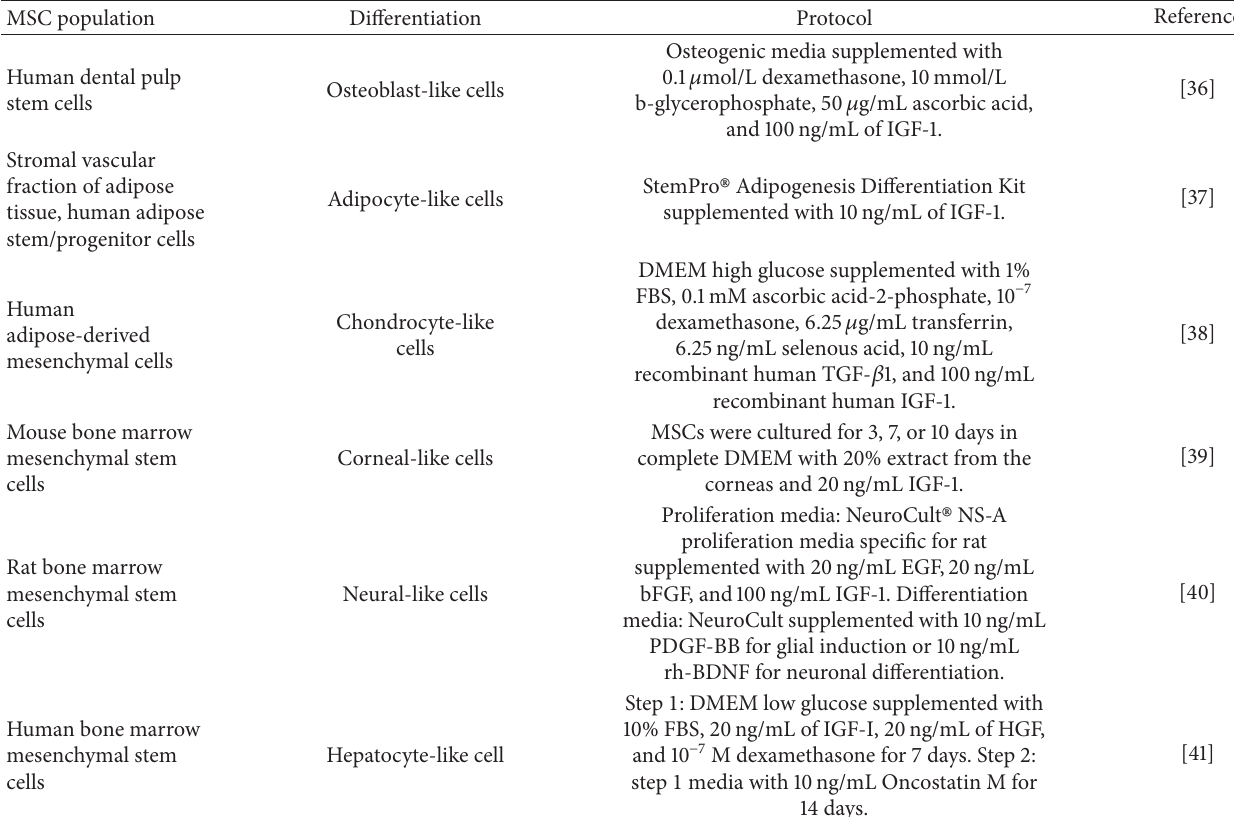
Table 1: MSC differentiation protocols with IGFs towards different lineages. Example of MSC differentiation protocols included IGFs in their differentiation media